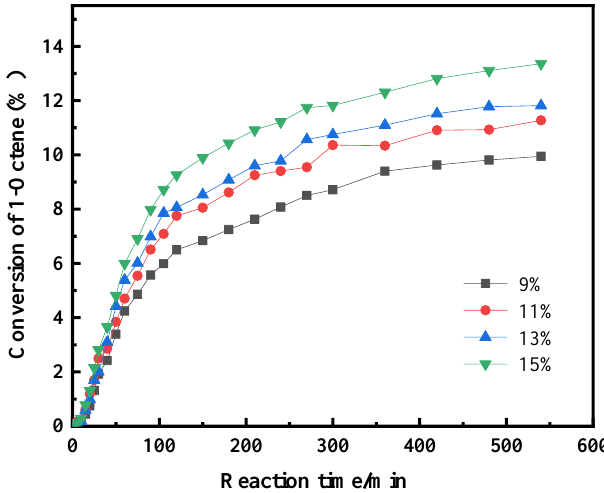
Figure 5. Effect of catalyst content on the reaction.